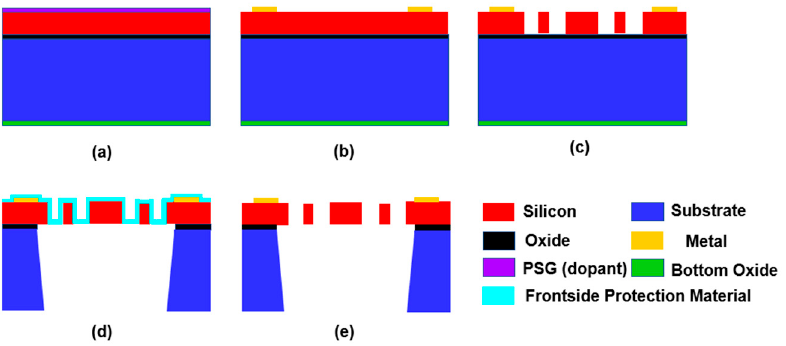
Figure 7. The chip fabrication flow.